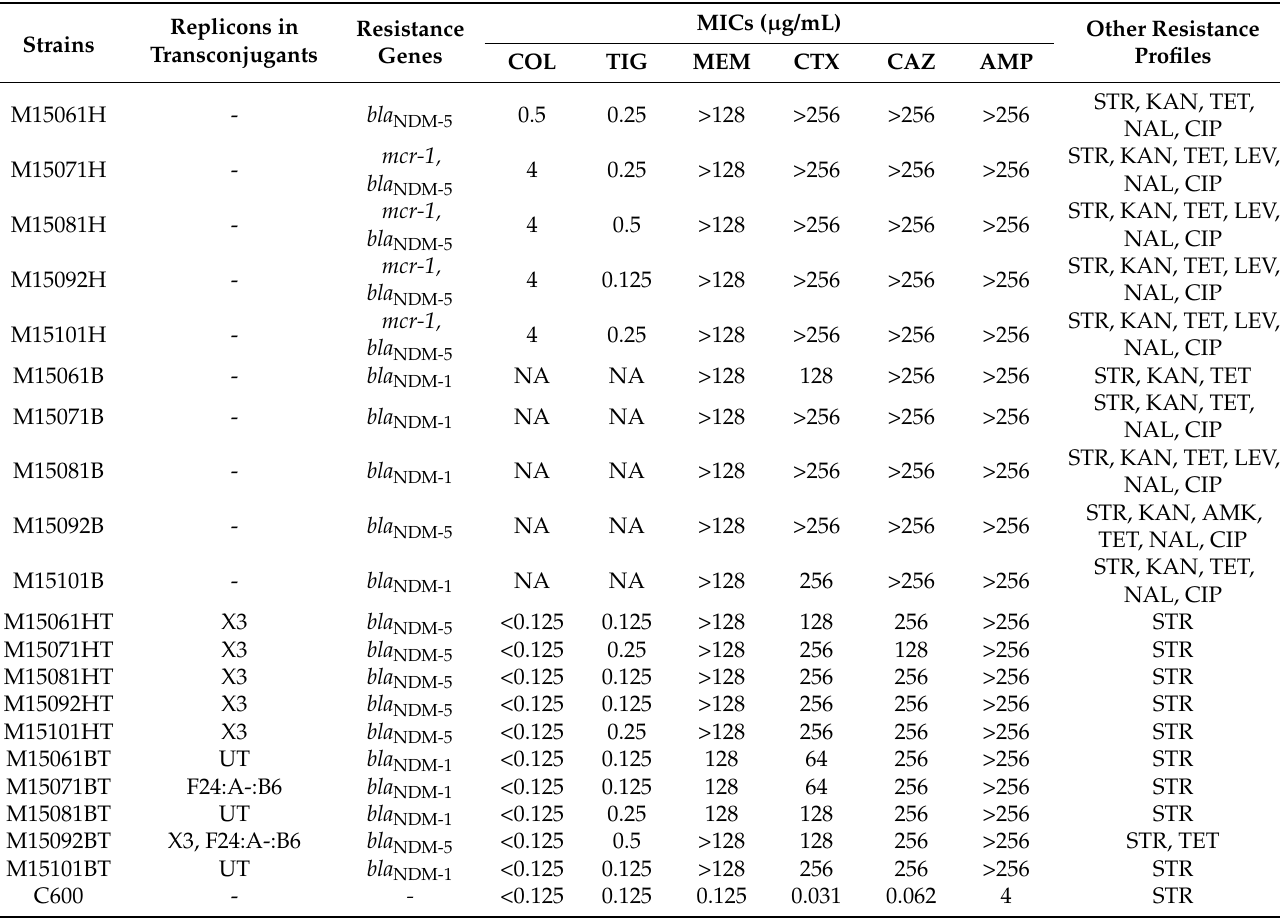
Table 2. Resistance characteristics of the 10 bla NDM -positive isolates and their transconjugants harboring bla NDM in this